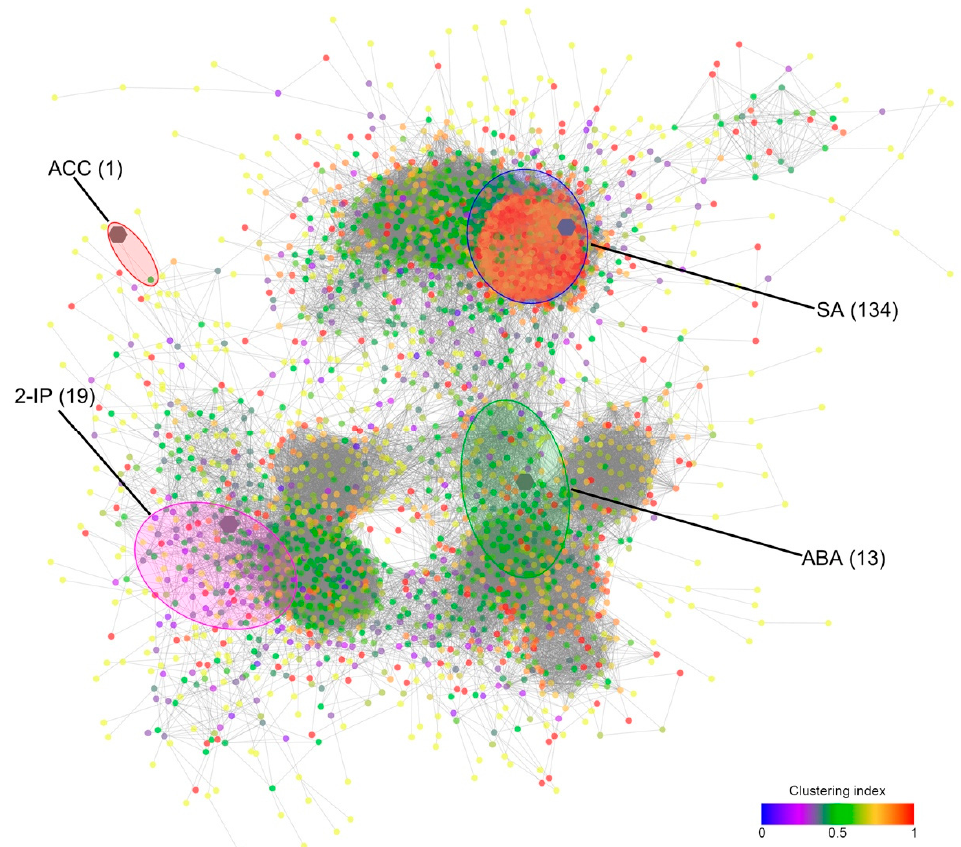
Figure 8. Correlative network built with genes (circles) and hormones (hexagons) according to their correlation index (ABA, abscisic acid; ACC, 1-aminocyclopropane-carboxylic acid; 2-IP, 2-isopentenyladenine; SA, salicylic acid). Only nodes with correlations higher than 0.8 in their absolute values were included. Node color represents the clustering index as shown in the bottom-right color scale. Subnetworks, including the first neighbor nodes directly connected to each hormone, are also shown with ellipses of different colors and the number of genes between parentheses. The network is shown with the ‘Prefuse Force Directed’ layout based on the parameter ‘Edge